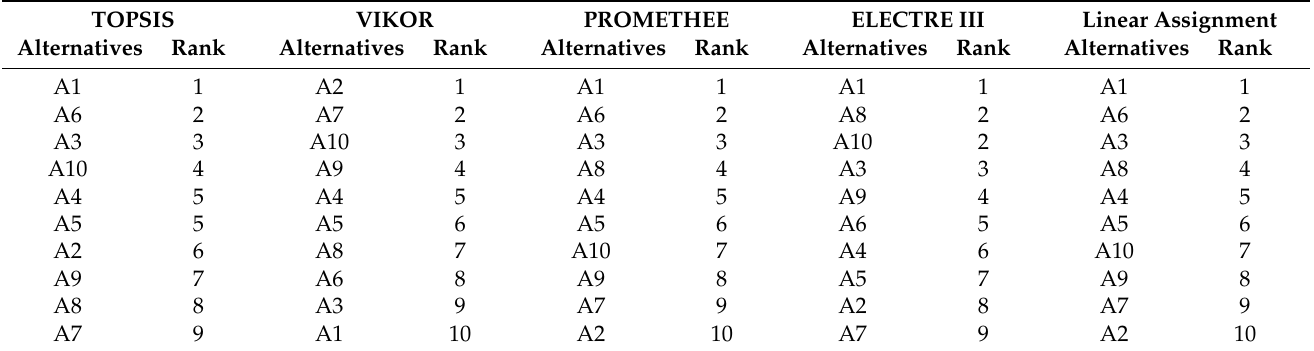
Table 6. Results of